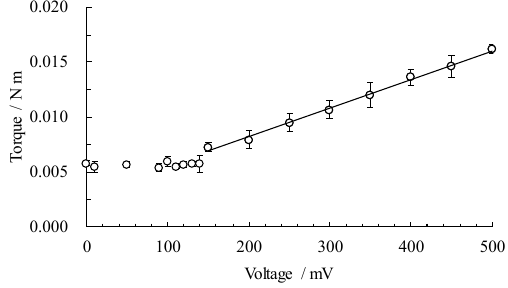
Figure 4. Relation between electric voltage and torque.